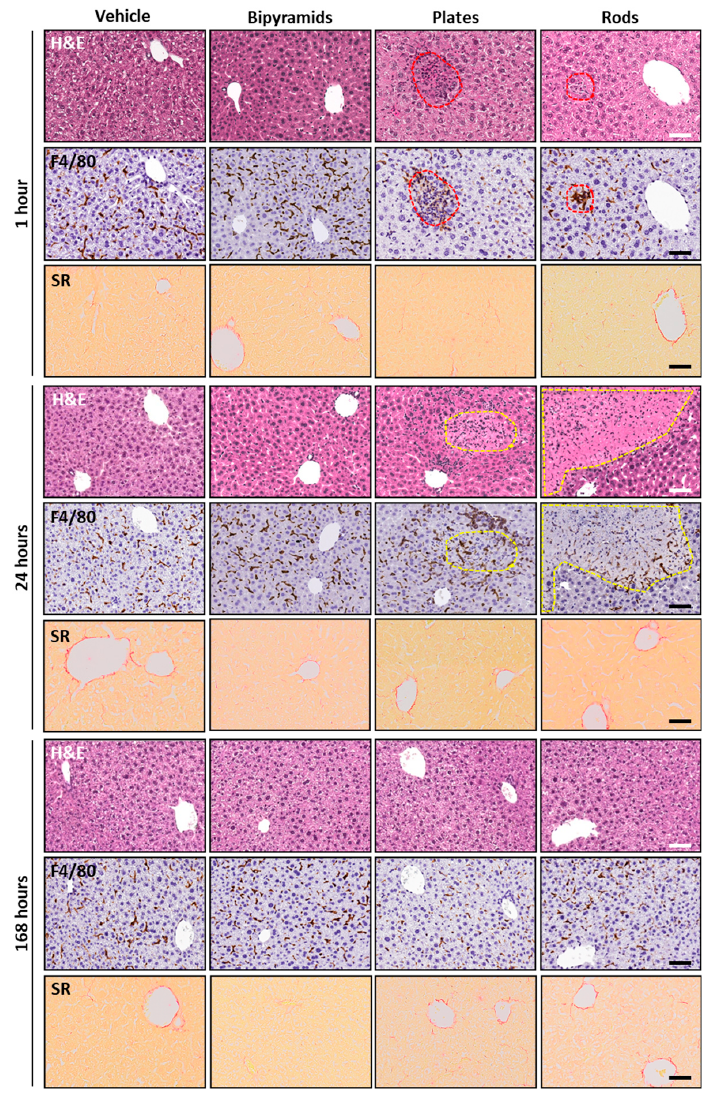
Figure 7. Liver histopathology and immunohistochemistry. Representative micrographs (H&E, upper panels, immunohistochemical staining, F4/80, middle panels and Sirius Red, lower panels) of the liver from mice injected with bipyramids, plates and rods, compared to vehicle-treated mice sacrificed at 1, 24 and 168 h after NP injection. Red hatched lines indicate microaggregation of F4/80 positive macrophages; yellow hatched lines indicate areas of hepatic infarcts. The scale bars represent 100 µm.